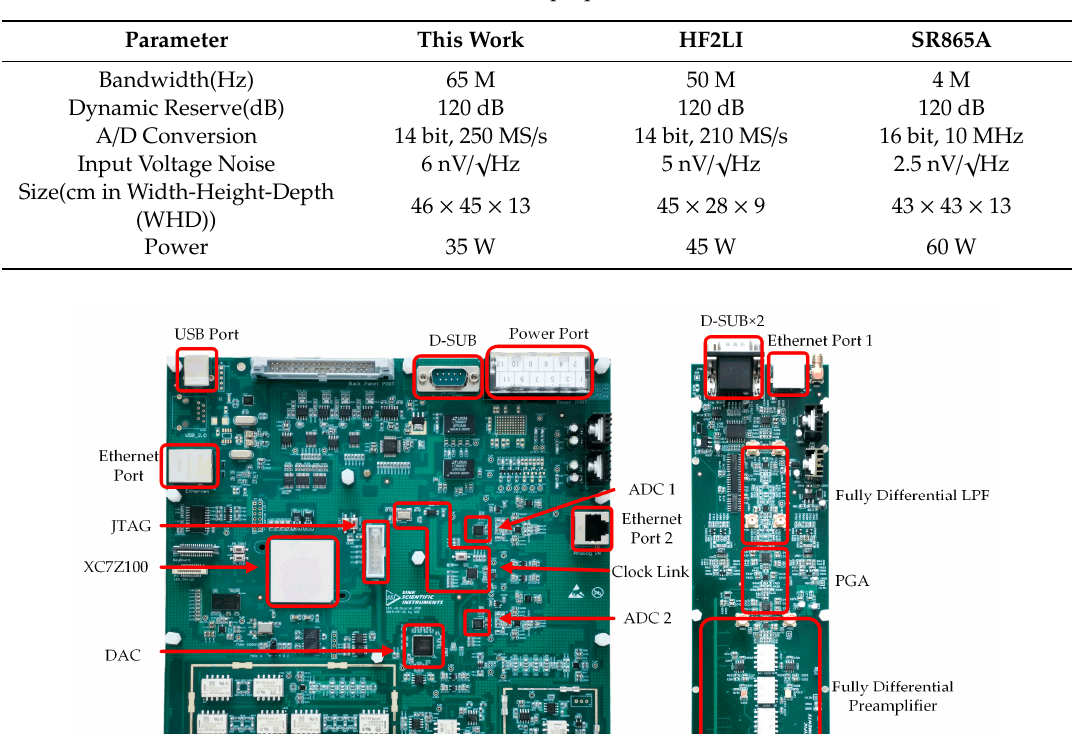
Table 1. The Characteristics of the proposed DLIA and other LIAs.